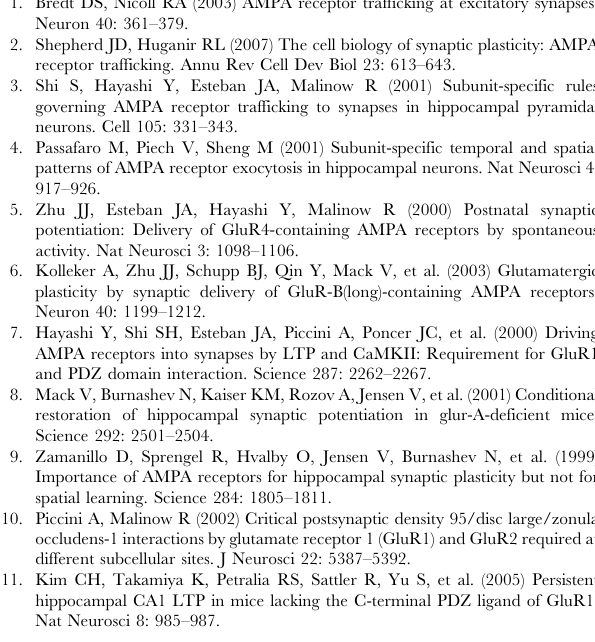
D P IgG only detects GluA2 D S. (B) Preincubation of anti- D P IgG L with molar excess of 13mer peptide prevented detection of recombinant GluA2 L D S (right hand panel). (C) GluA2 L D S binds to SAP97 PDZ domains. Extracts of HEK293 cells expressing Flag-tagged GluA2 L and GluA2 L D S were incubated with SAP97[PDZ1-3] GST fusion protein. Input (upper) panel indicates similar expression of GluA2 proteins. The lower panel shows only GluA2 L D S is pulled down with the PDZ domains. Both blots were probed with anti-Flag IgG. Figure S6 4.1N interacts with SAP97 and AMPA receptors. Mouse brain extract was subjected to immunoprecipitation with the antibodies indicated on top and the samples were probed with anti-4.1N antibody [47]. 4.1N was present in the immunoprecip- itates produced by antibodies specific for SAP97, PSD-95 Maguks (anti-PDZ) and GluA2/GluA4 AMPA receptor subunits (Fab7). Found at: doi:10.1371/journal.pone.0008715.s006 (0.18 MB TIF) Table S1 Monoisotopic peptide masses observed in the mass spectrometric analysis of , 100 kDa band in anti-BD L IgG immunoprecipitate from adult rat crebellum and theoretical mases of tryptic peptides of rat AMPA receptor subunits. Table S2 Monoisotopic peptide masses observed in the mass spectrometric analysis of , 100 kDa band in anti- D P IgG immunoprecipitate from adult rat crebellum and theoretical mases of tryptic peptides of rat dynamin isoforms. C-terminal peptide is